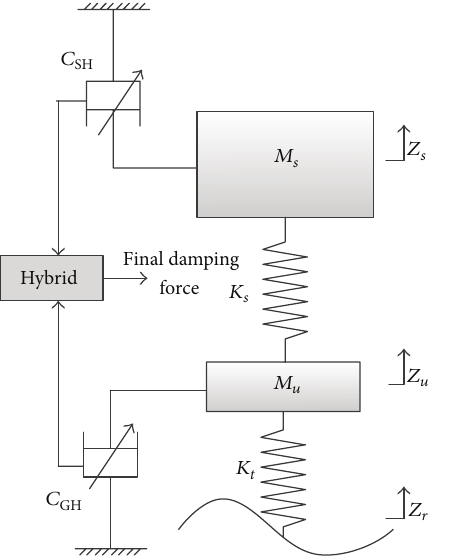
Figure 6: Quarter-vehicle SAS system model with fuzzy-hybrid- ADD and